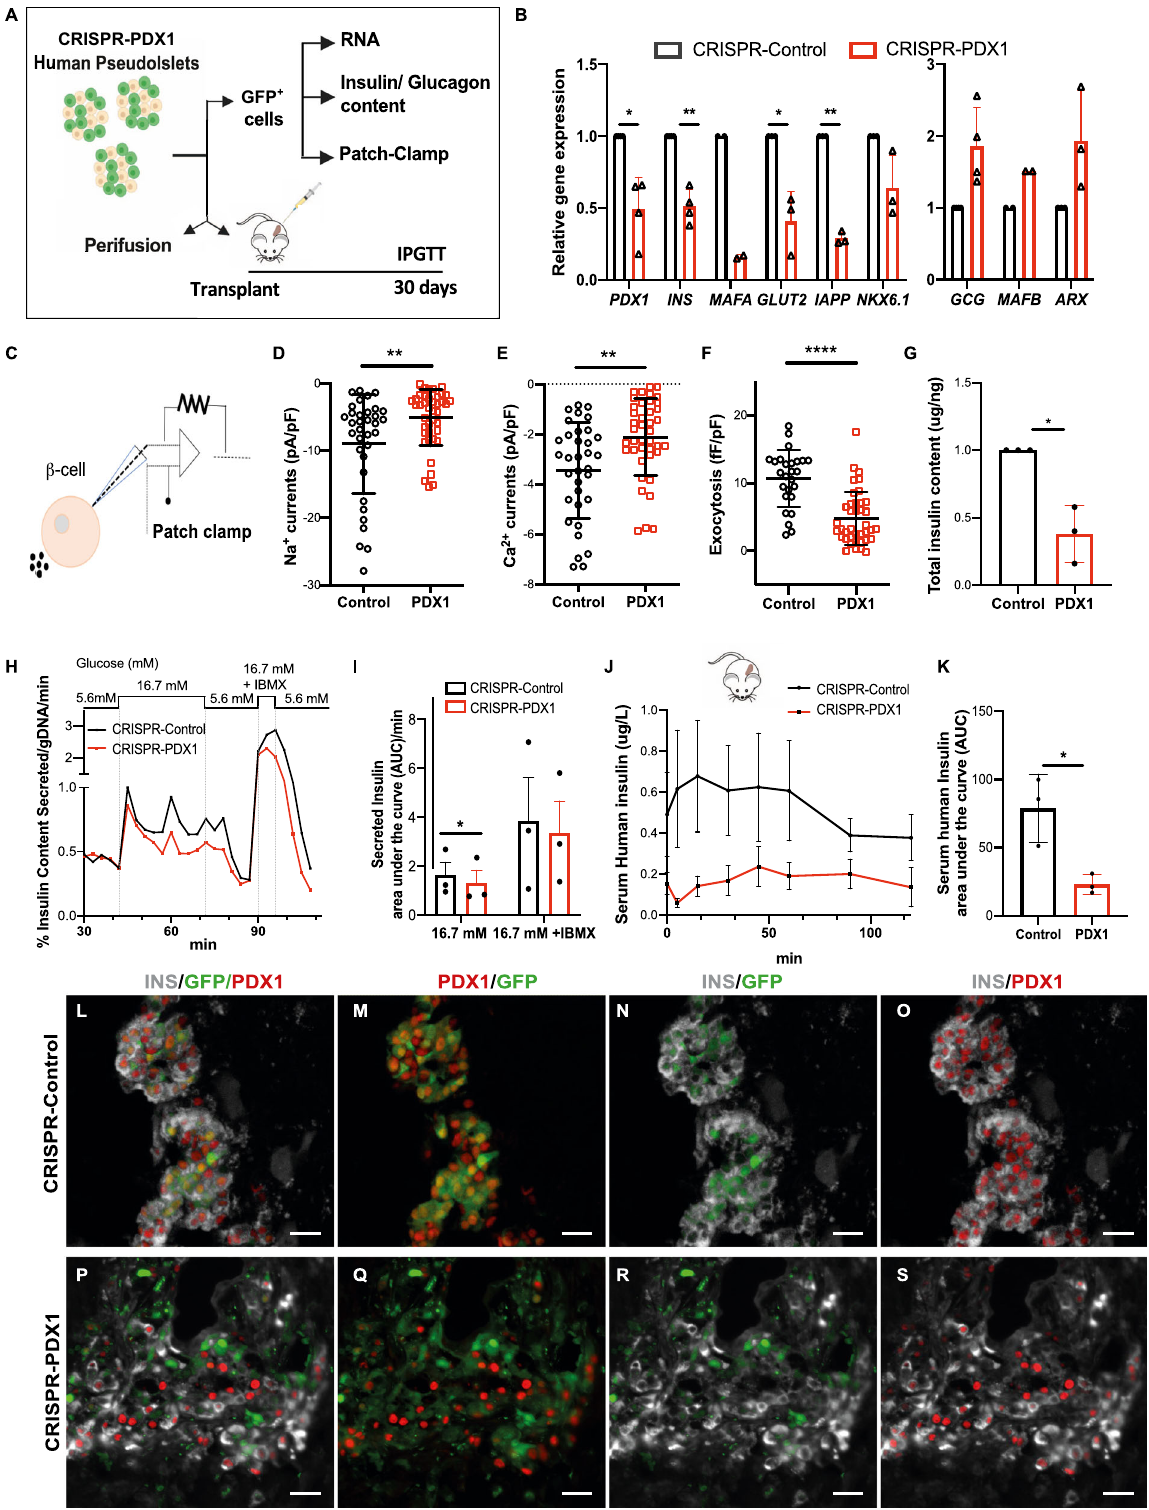
for controls), and a corresponding signi fi cant reduction in human insulin output for the CRISPR-PDX1 condition (Fig. 2K: area under the curve, AUC: P < 0.05; Methods). Serum glucose levels after IPGTT were indistinguishable in mice transplanted with CRISPR- PDX1 or control pseudoislets (Supplementary Fig. 3K – L), likely re fl ecting intact host islet function. Compared to control grafts, immunostaining of grafts with PDX1 targeting showed reduced